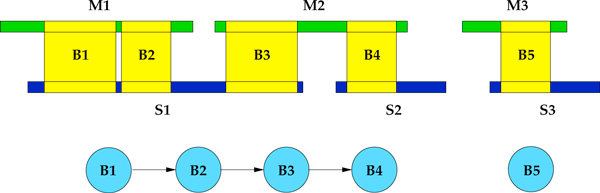
Assemblies Graph construction. A simple example of AG construction: B1 comes before B2 in both S1 and M1 so a directed edge connects VB1 and VB2. The same also applies for VB2 and VB3, since B2 comes before B3 in S1. Moreover, an edge is added between VB3 and VB4 as B3 comes before B4 in M2.